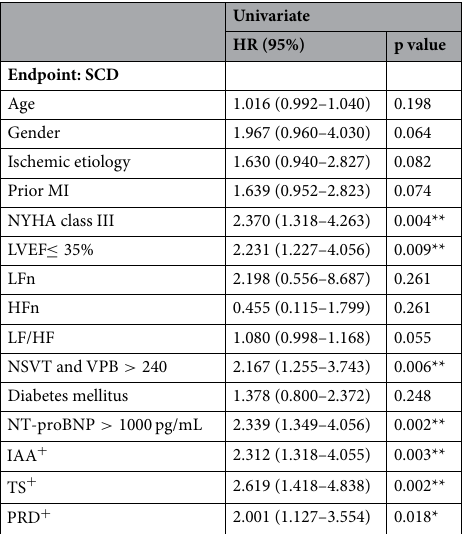
Table 2. Univariate Cox analysis for SCD as endpoint. Age, gender, ischemic etiology, prior myocardial infarction, NYHA class, LVEF, HRV indices (LFn, HFn, LF/HF), combined NSVT and VPB > 240 , diabetes, NT-proBNP > 1000pg/mL , IAA + , TS + and PRD + were the analyzed variables. ∗ p < 0.05 , ∗∗ p < 0.01 .